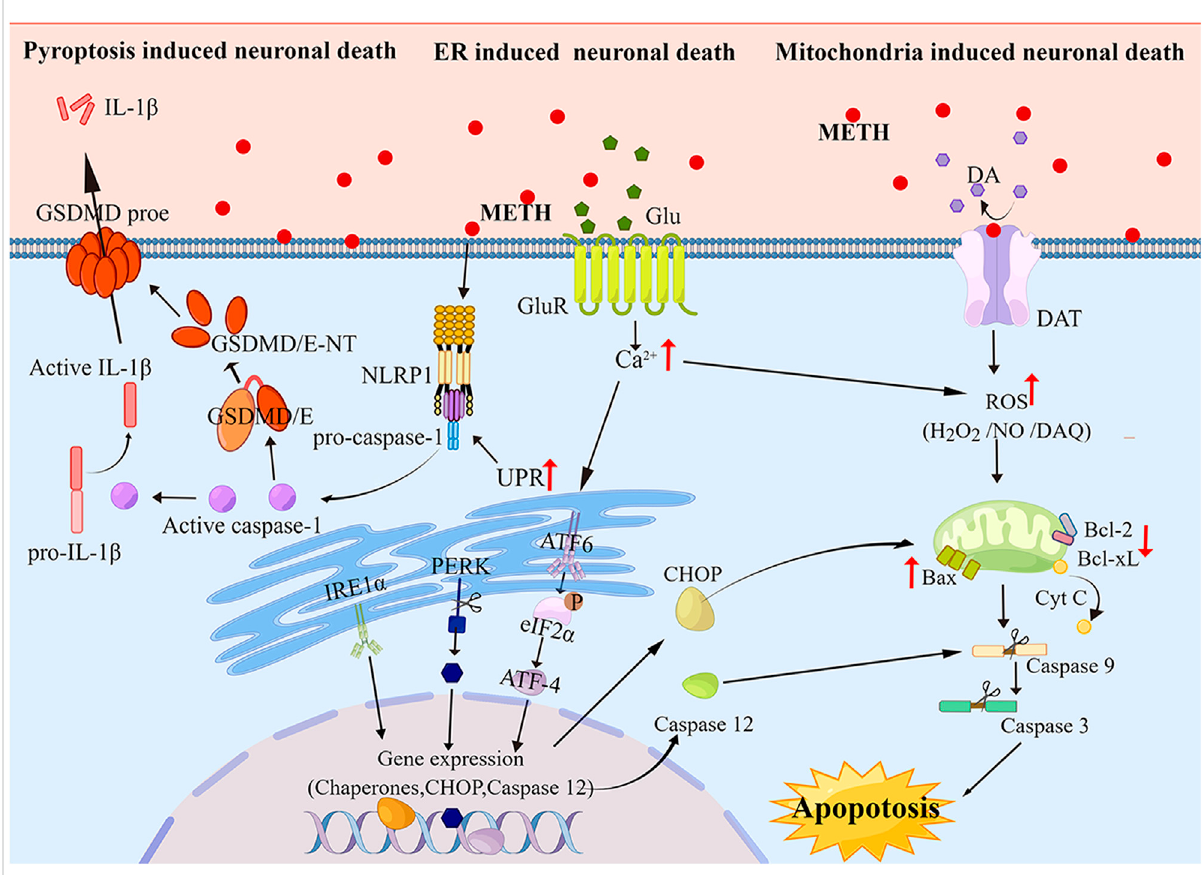
FIGURE 1 The Molecular pathways of apoptosis and pyroptosis induced by METH Neurotoxicity As METH induces apoptosis and pyroptosis via neurotoxicity pathways, it produces ROS and Ca2 + that act as secondary messengers for mitochondria-and ER-mediated apoptosis and pyroptosis. Furthermore, ER stress can activate the pyroptotic pathway, leading to the cleavage of GSDME, subsequently cleaving the cytoplasmic membrane and releasing cellular